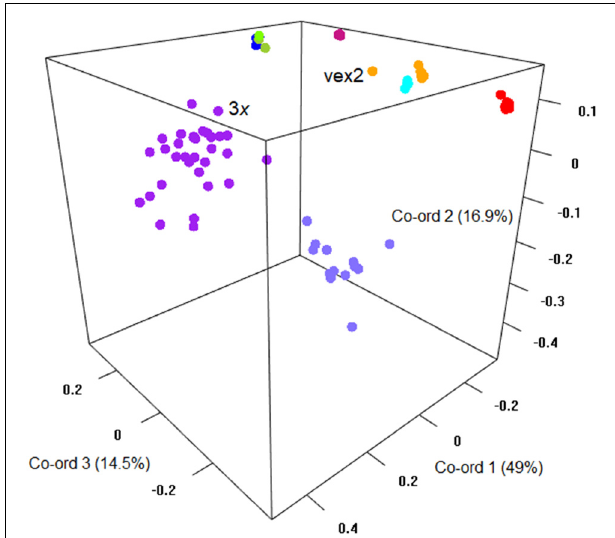
FIGURE 3 | Principal coordinate analysis of the Bruvo distance matrix of 80 MLGs from nine species based on 10 microsatellite loci. Percentages of total variance explained by the co-ordinates are given in parentheses. Currently recognized taxa are indicated as follows: • S. aria, • S.